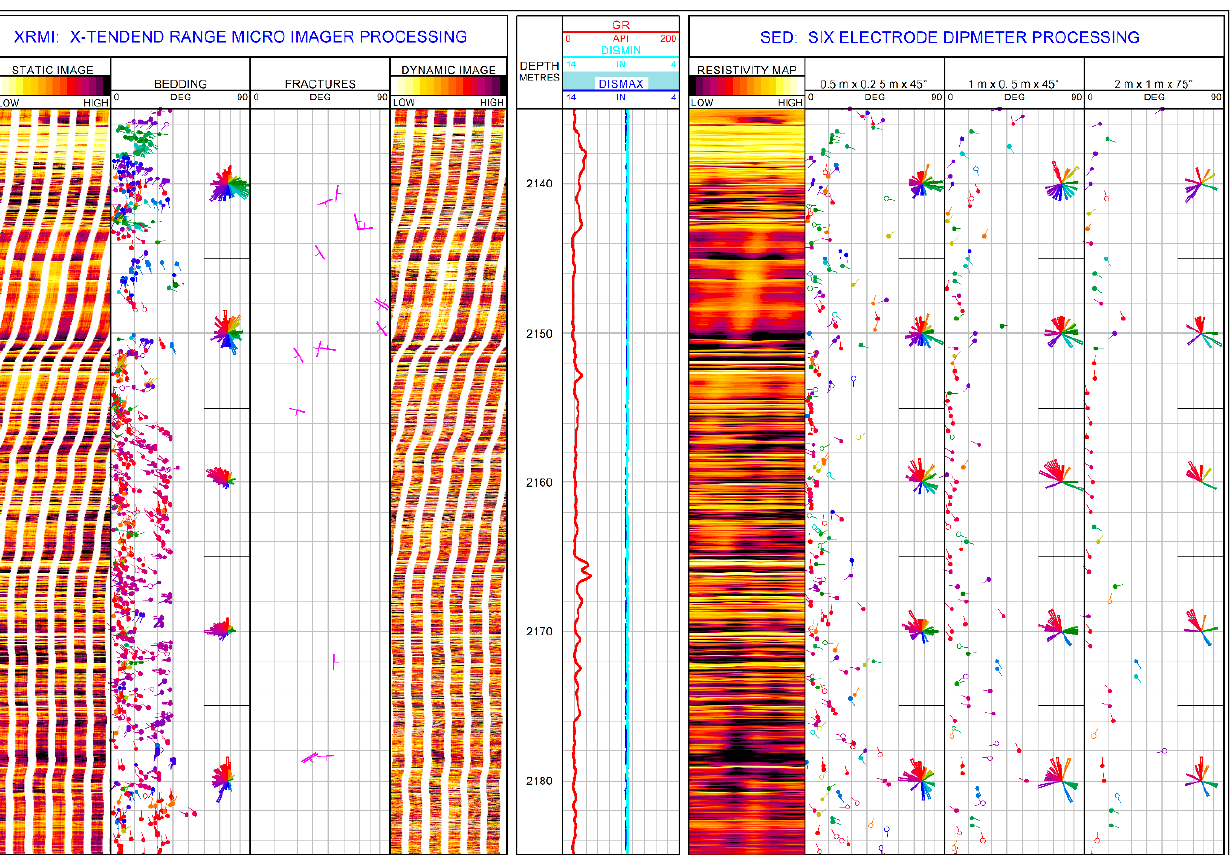
Figure 10. Sample of XRMI (left) and SED (right) plots after processing; GT ‐ 1, J2, Ksawerów and K ł odawa Beds, 2132–2182 m, thick ‐ layered sandstones; bedding is distinctly visible in the static image of XRMI (first track) and Resistivity Map from SED (seventh track); dips are presented as coloured vectors in the second track—XRMI and eighth ‐ tenth tracks—SED; coloured azimuth roses (second track—XRMI and eighth ‐ tenth tracks—SED) show the dominating dips and azimuths; groups of fractures resulted from processing of XRMI image are in the third track; depth is marked in the fourth track; in the fifth track—GR and two calipers, DISMIN and DISMAX are presented; results of SED processing with different parameters are shown in the next tracks: eighth—0.5 m × 0.25 m × 45, ninth—1 m × 0.5 m × 45 and tenth—2 m × 1 m × 75; colour scale in the Static and Dynamic images and Resistivity Map is related to lower (darker) and higher (lighter) resistivity.